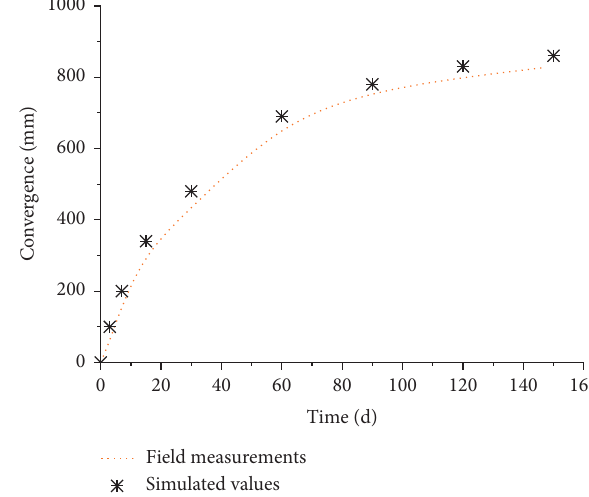
Figure 4: The comparison between measured convergences and calculated convergences in the representative roadway cross section.